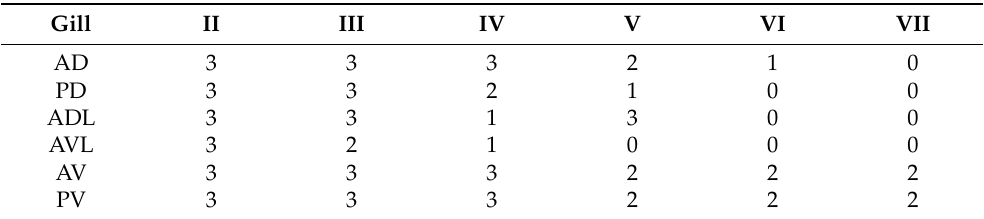
Table 4. Number of types of tracheal gills on abdominal segments II–VII of final instar larvae of Limnephilus deqianensis n. sp. Positions abbreviated as: A = anterior, D = dorsal, L = lateral, P = posterior, V = ventral.